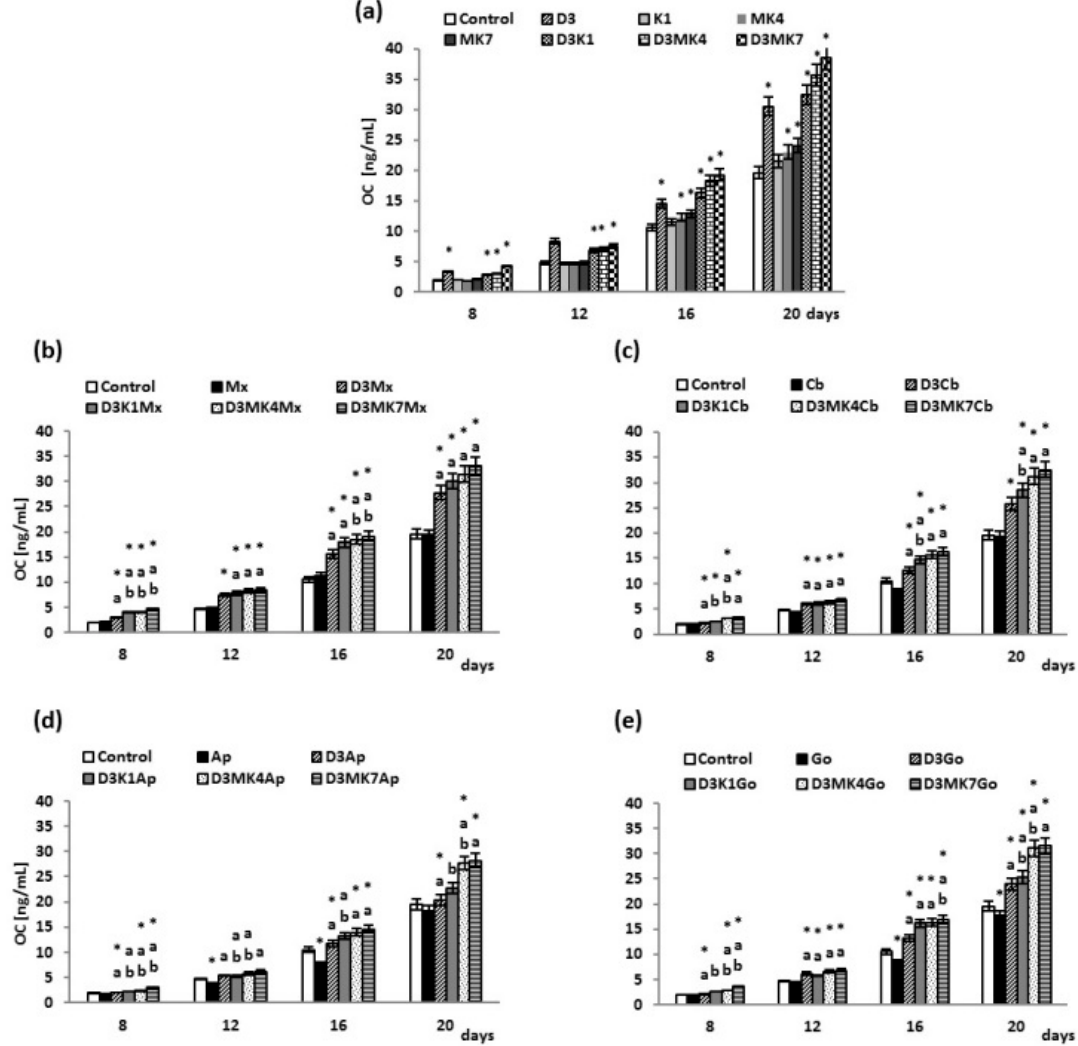
Figure 7. OC levels in osteoblasts after incubation with hydroxyapatites and treated with vitamins D3, K1, MK4, and MK7 after 8, 12, 16, and 20 days. The results are expressed as the ng/mL of medium and are shown as the mean ± SD ( n = 5). The values for the control cells and the treated cells were significantly different according to unpaired Student’s t -test. * Statistically significant differences versus control, p < 0.05; a statistically significant differences versus group hydroxyapatites (Mx (Maxgraft), Cb (Cerabone), Ap (Apatos), Go (Gen-Os), respectively for graphs (b), (c), (d),(e)), p < 0.05. b statistically significant differences versus group vitamin D 3 with hydroxyapatites (Mx (Maxgraft), Cb (Cerabone), Ap (Apatos), Go (Gen-Os), respectively for graphs (b), (c), (d),(e)), p < 0.05.